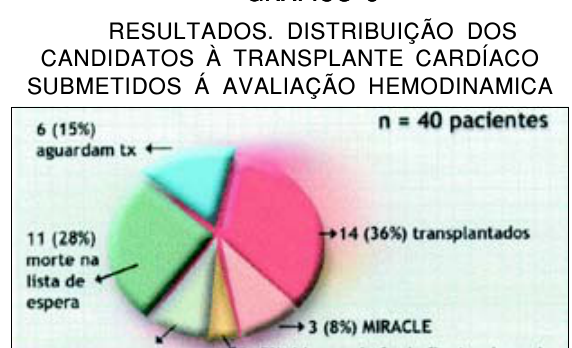
Fig. 6 (cid:150) Sistema de administra(cid:231)ªo do NO, cilindro, conexıes e na parte superior o analisador de NO e NO